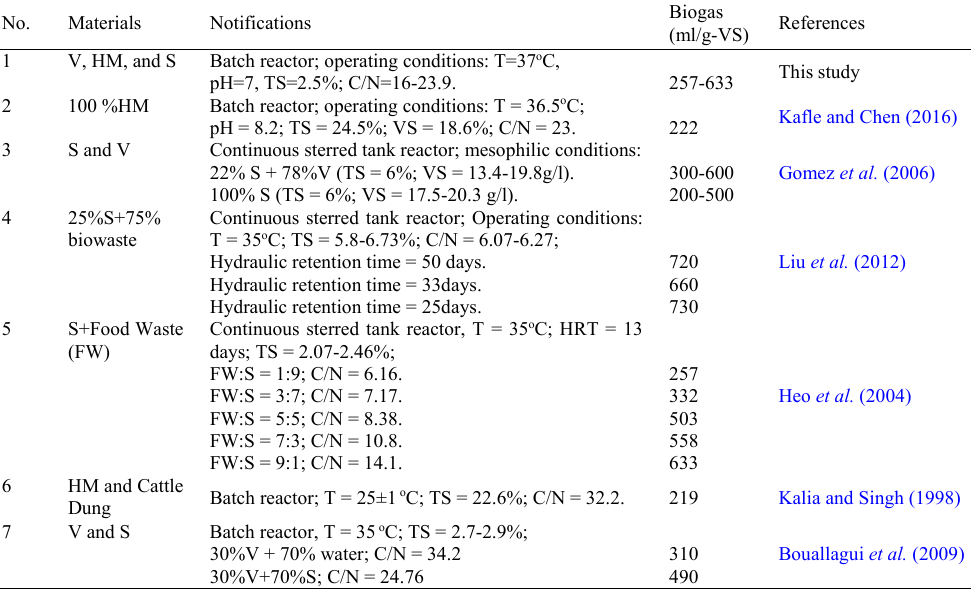
Table 3: Biogas yield from digestion of vegetable, horse manure, and sludge